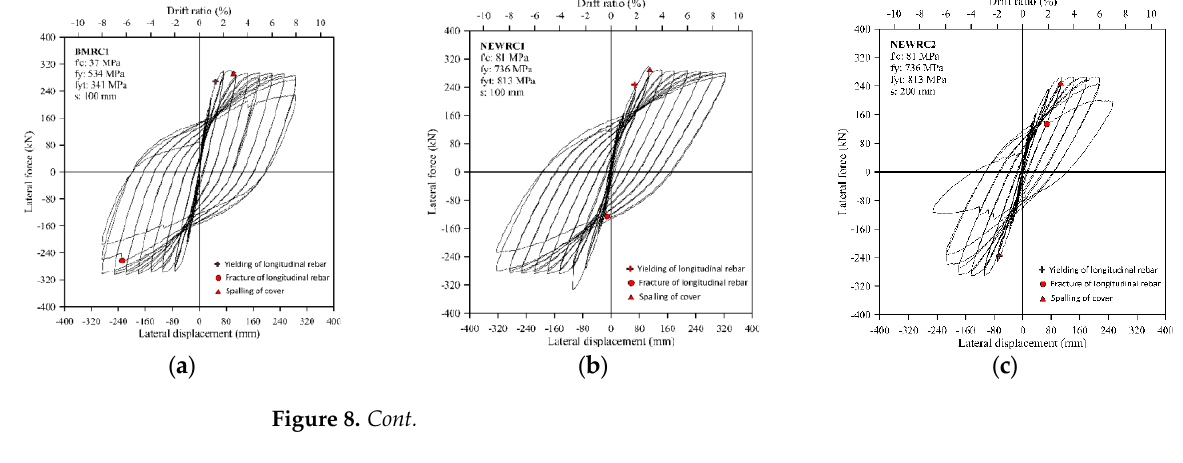
Figure 7. Crack pattern at damage at the end of the test NEWRCF: ( a ) P1-Top; ( b ) P1-Bot; ( c ) P2-Top; ( d ) P2-Bot.